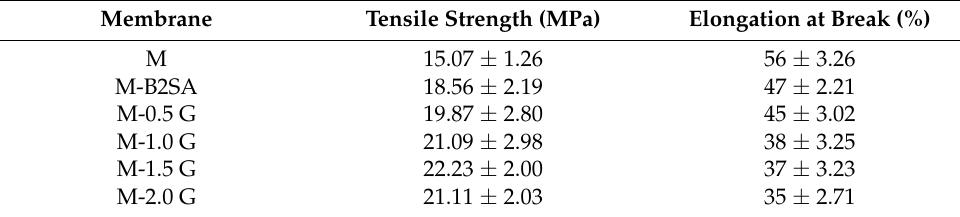
Table 1. Mechanical properties of the graphene-loaded hybrid PVA membranes.